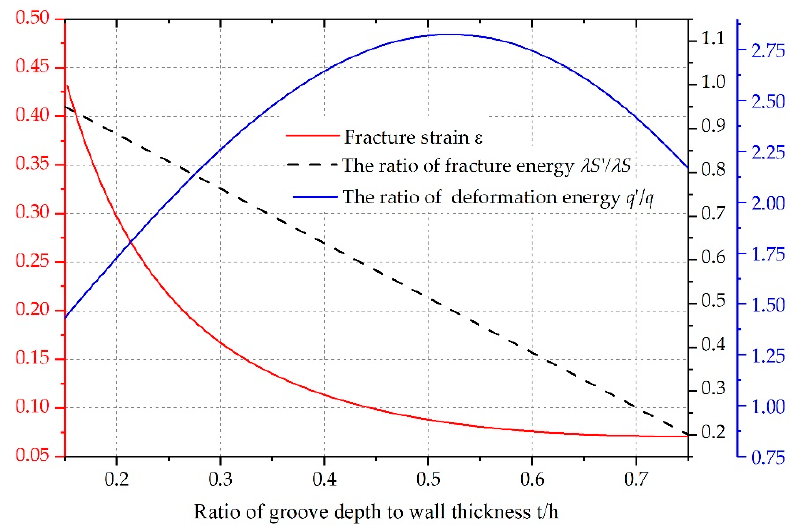
Figure 21. Fracture strain (red line), ratio of elastic energy per unit volume q (cid:48) / q (blue line), and ratio of total fracture energy λ S (cid:48) / λ S (dashed black line).